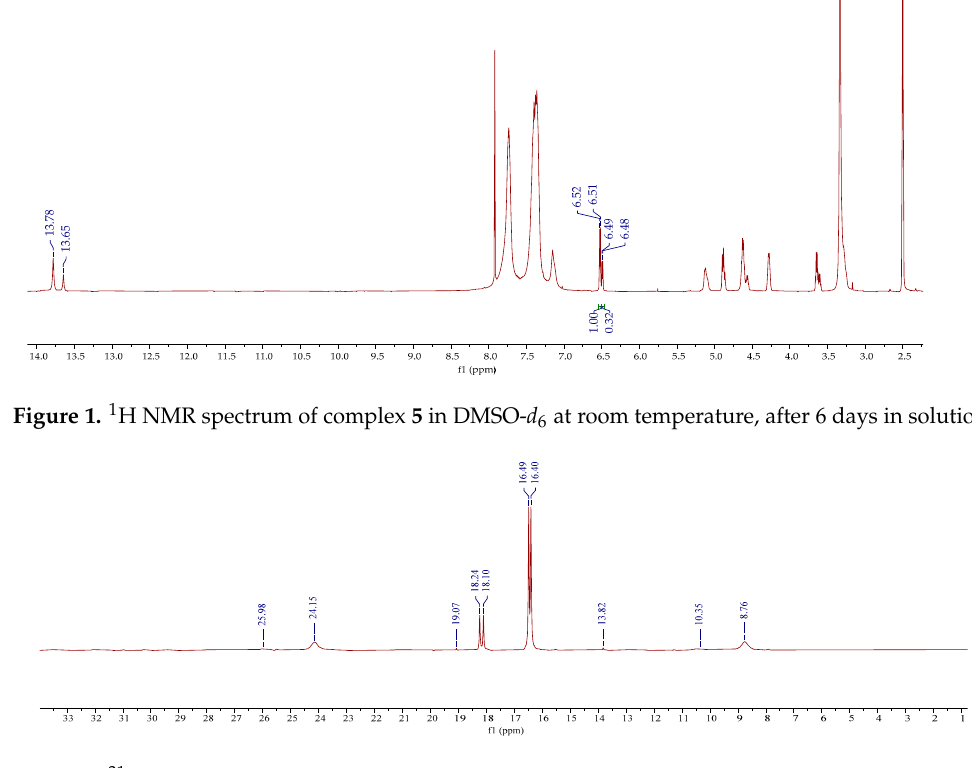
Figure 2. 31 P NMR spectrum of complex 5 in DMSO- d 6 at room temperature, after 4 days in solution.